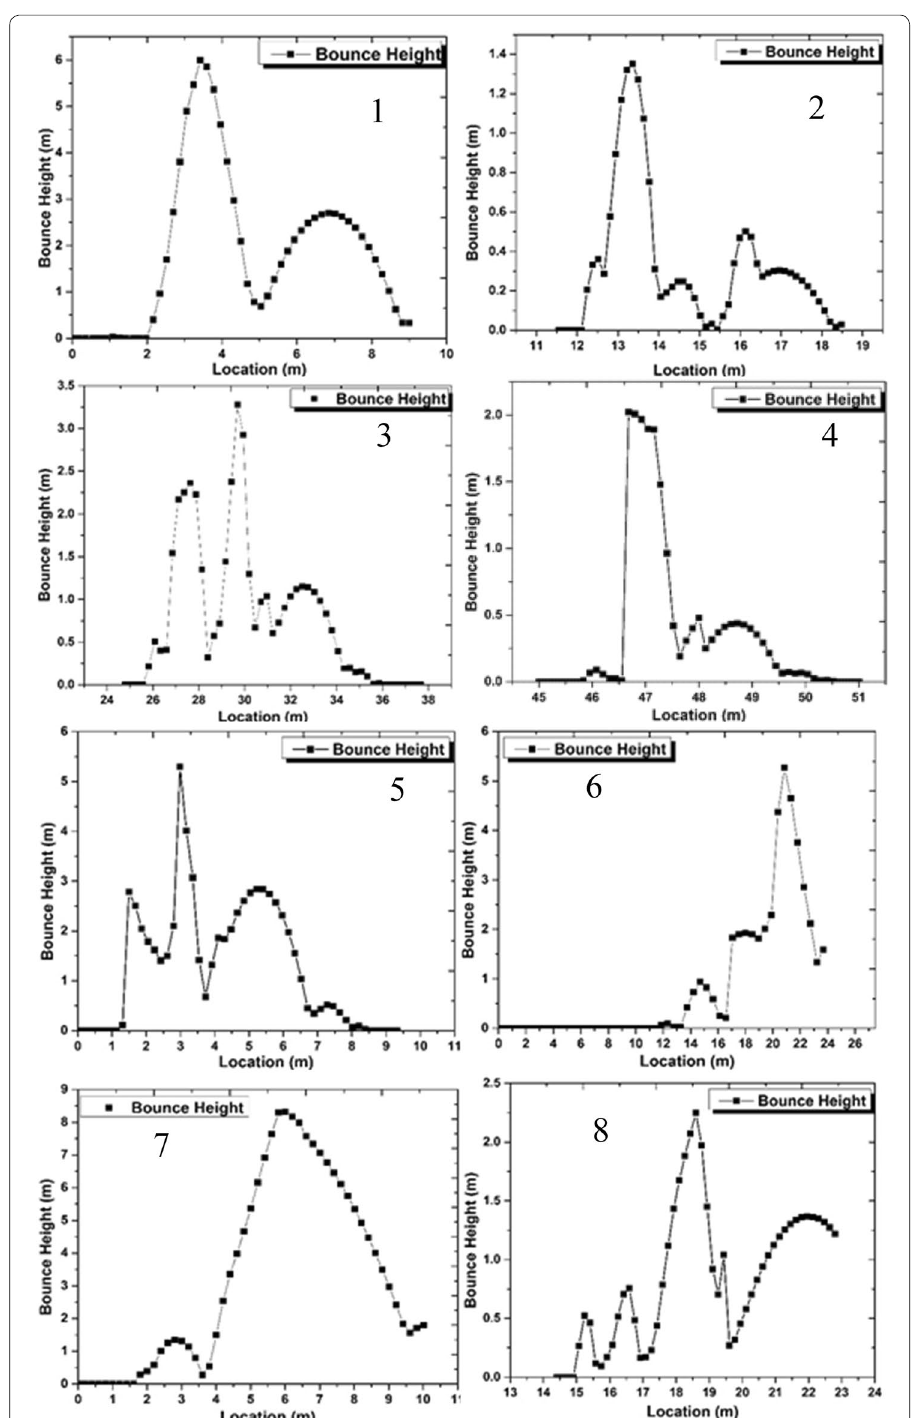
Fig. 6 RocFall models of bounce height for eight cut slope